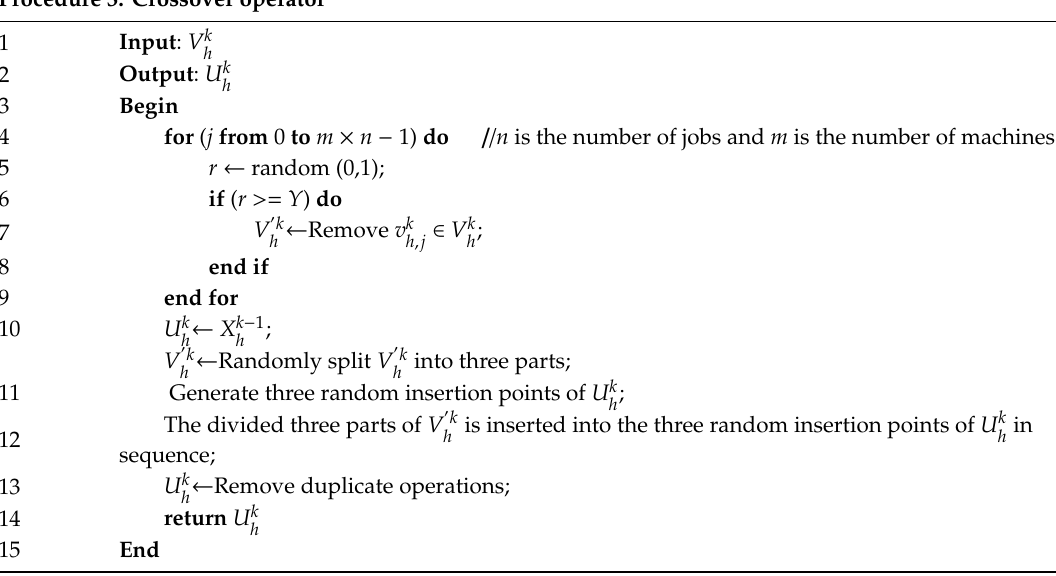
Table 3. Generation of temporary vector G k